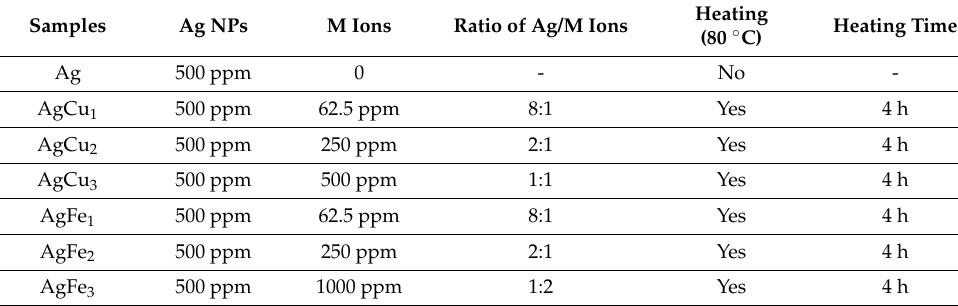
Table 1. Parameters of the NA